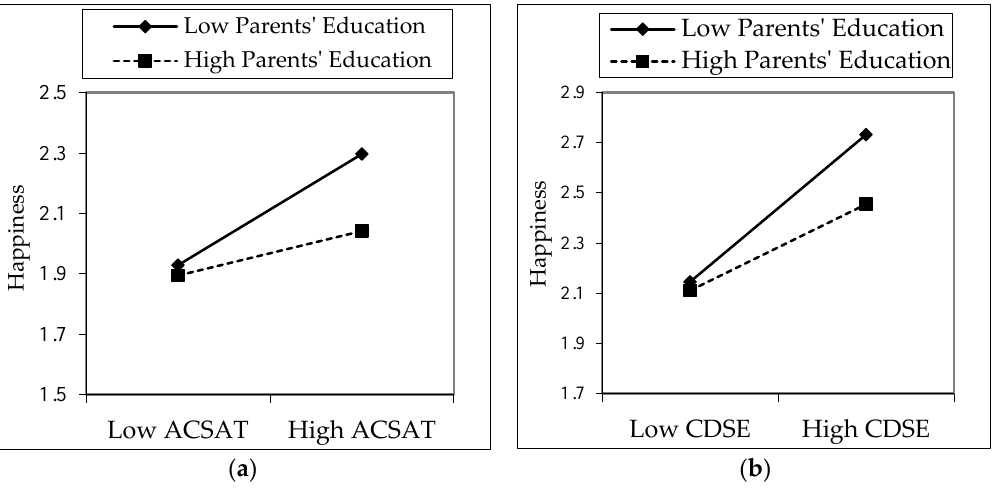
Figure 2. Moderation effect of parents’ education on the impact of ACSAT ( a ) and CDSE ( b ) on happiness.